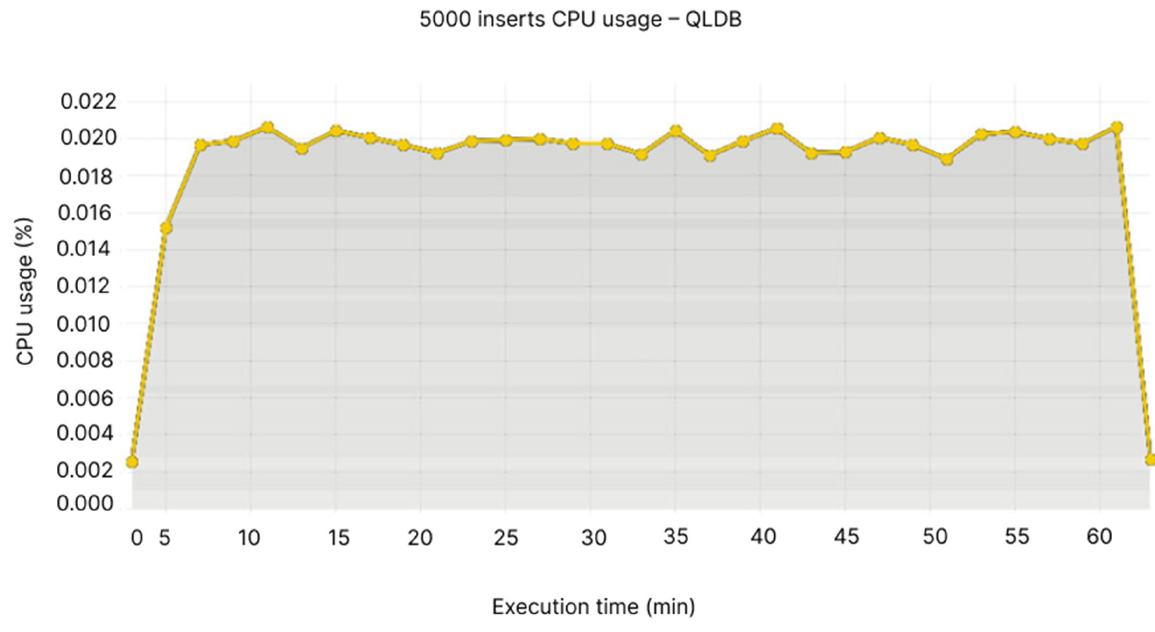
Figure 11. 5000 inserts CPU usage—QLDB.